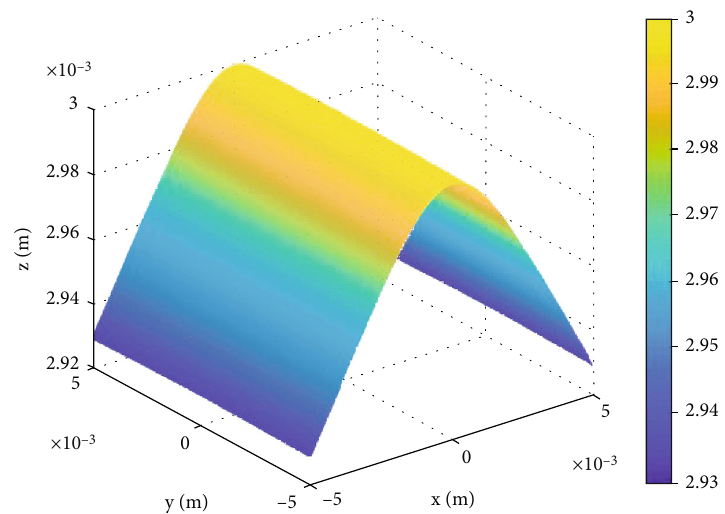
Figure 7: Optical free curved surface for laser transmitting system.